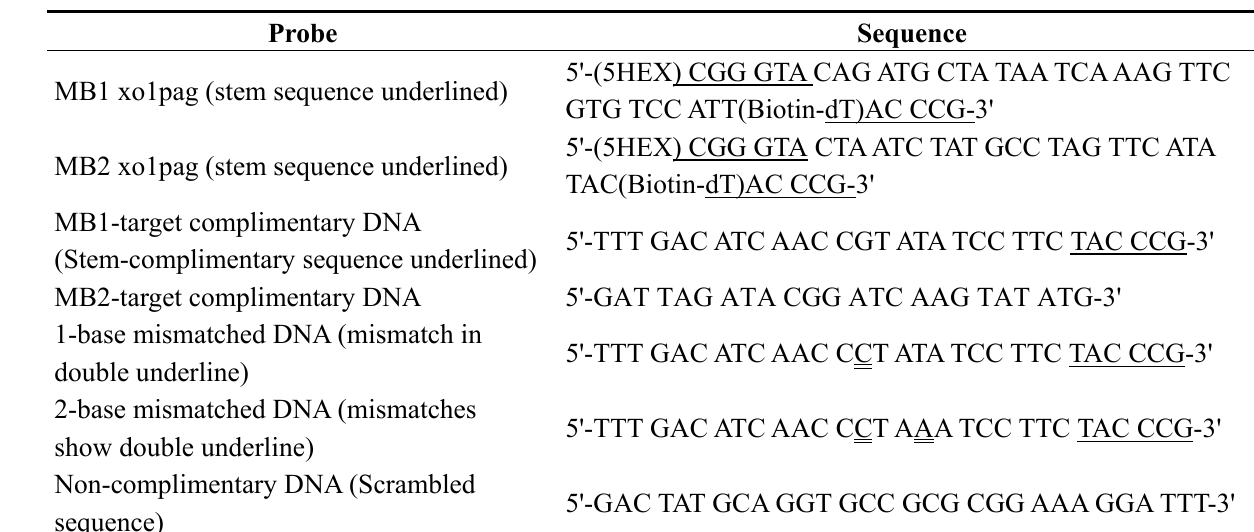
Table 1. Illustrates the sequences of the complementary oligonucleotides and the sequences underlined identifies the stem, and the double underlined the mistmatch introduced. HEX refers to the fluorophore and BHQ1 (Black Hole Quencher 1) to the